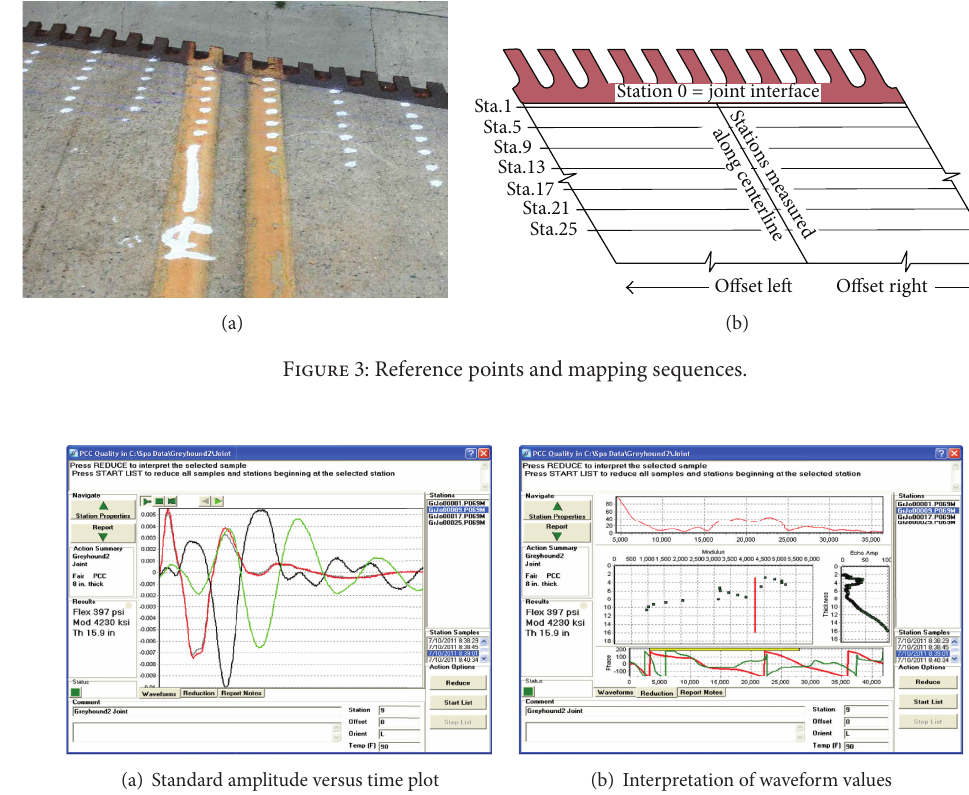
Figure 4: Data processing windows in PSPA